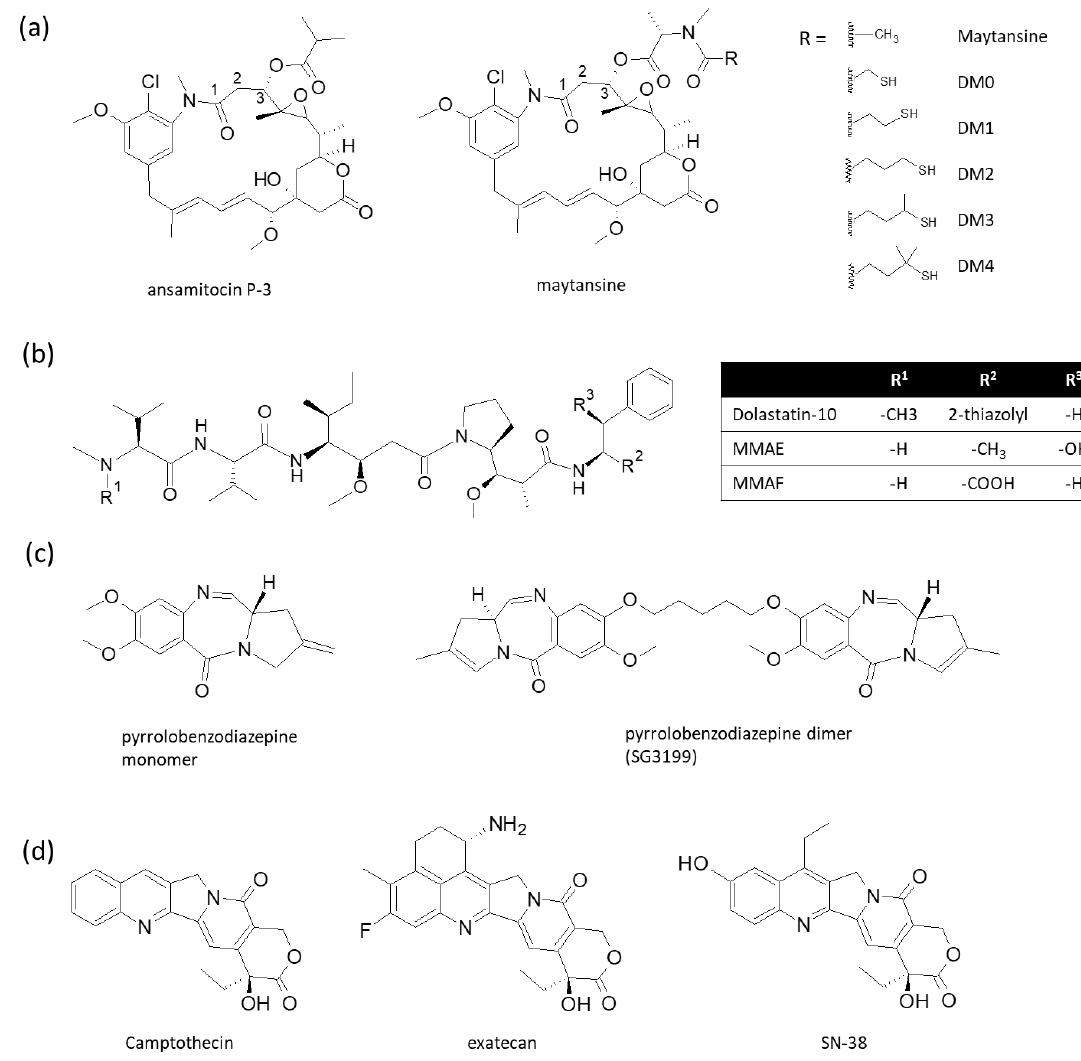
Figure 2. Structures of commonly used antibody–drug conjugate (ADC) payloads. ( a ) Structures of maytansinoids and their semisynthetic precursor, ansamitocin P-3. ( b ) Structures of auristatin. “Monomethyl” (“MM” of MMAE and MMAF) refers to the methylation status of the N-terminal amino group, which is dimethylated in the natural compound dolastatin 10. ( c ) Structures of PBD monomer and a dimer (SG3199). ( d ) Structures of camptothecin and its derivatives exatecan and SN- 38.